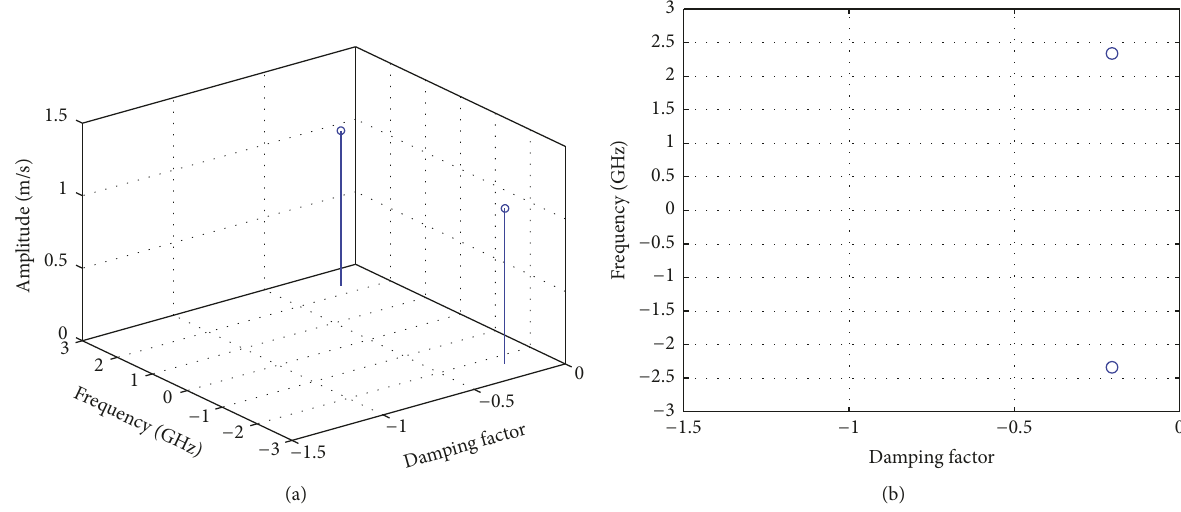
Figure 21: Using proposed enhanced MP method: (a) pole-residue relationship and (b) frequency versus damping factor.